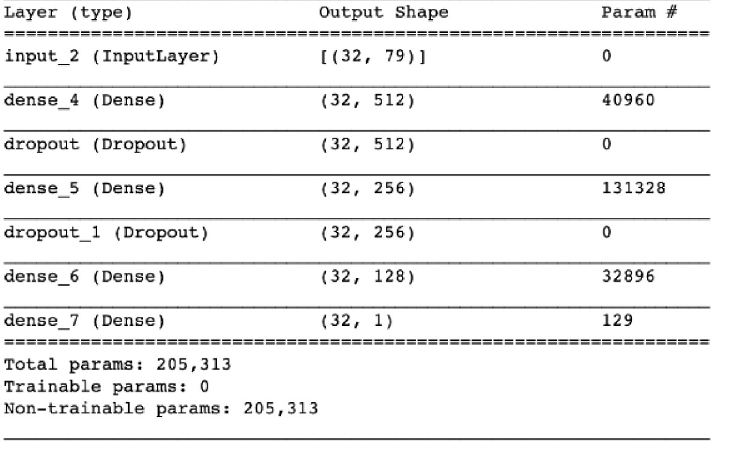
Fig 3. Discriminator network